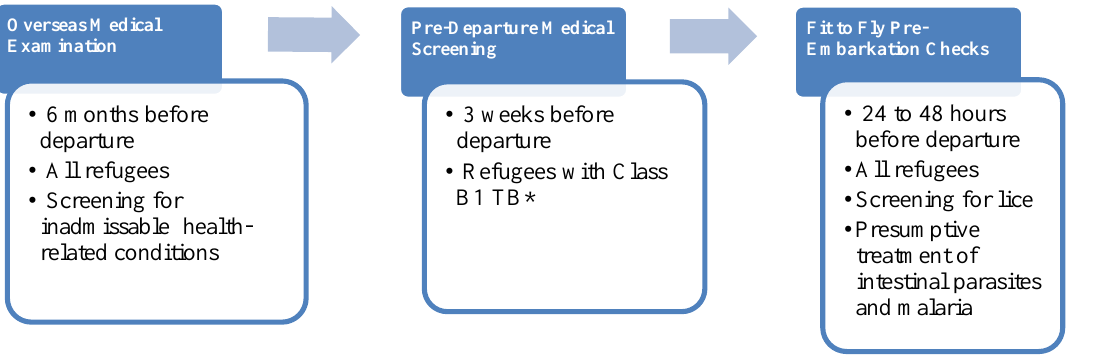
Figure 7: Medical assessment of United States-bound Congolese refugees